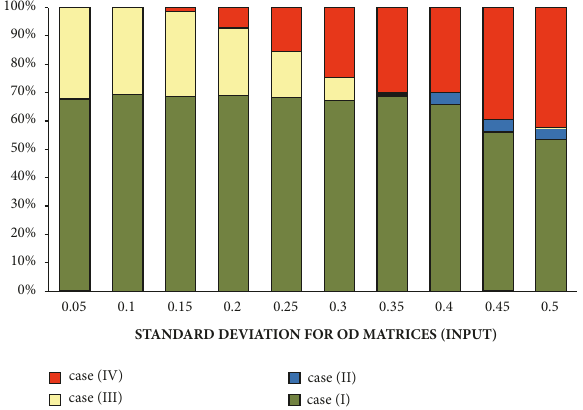
Figure 10: The predicted uncertainty for the link No. 6, applying extreme value distribution scenarios